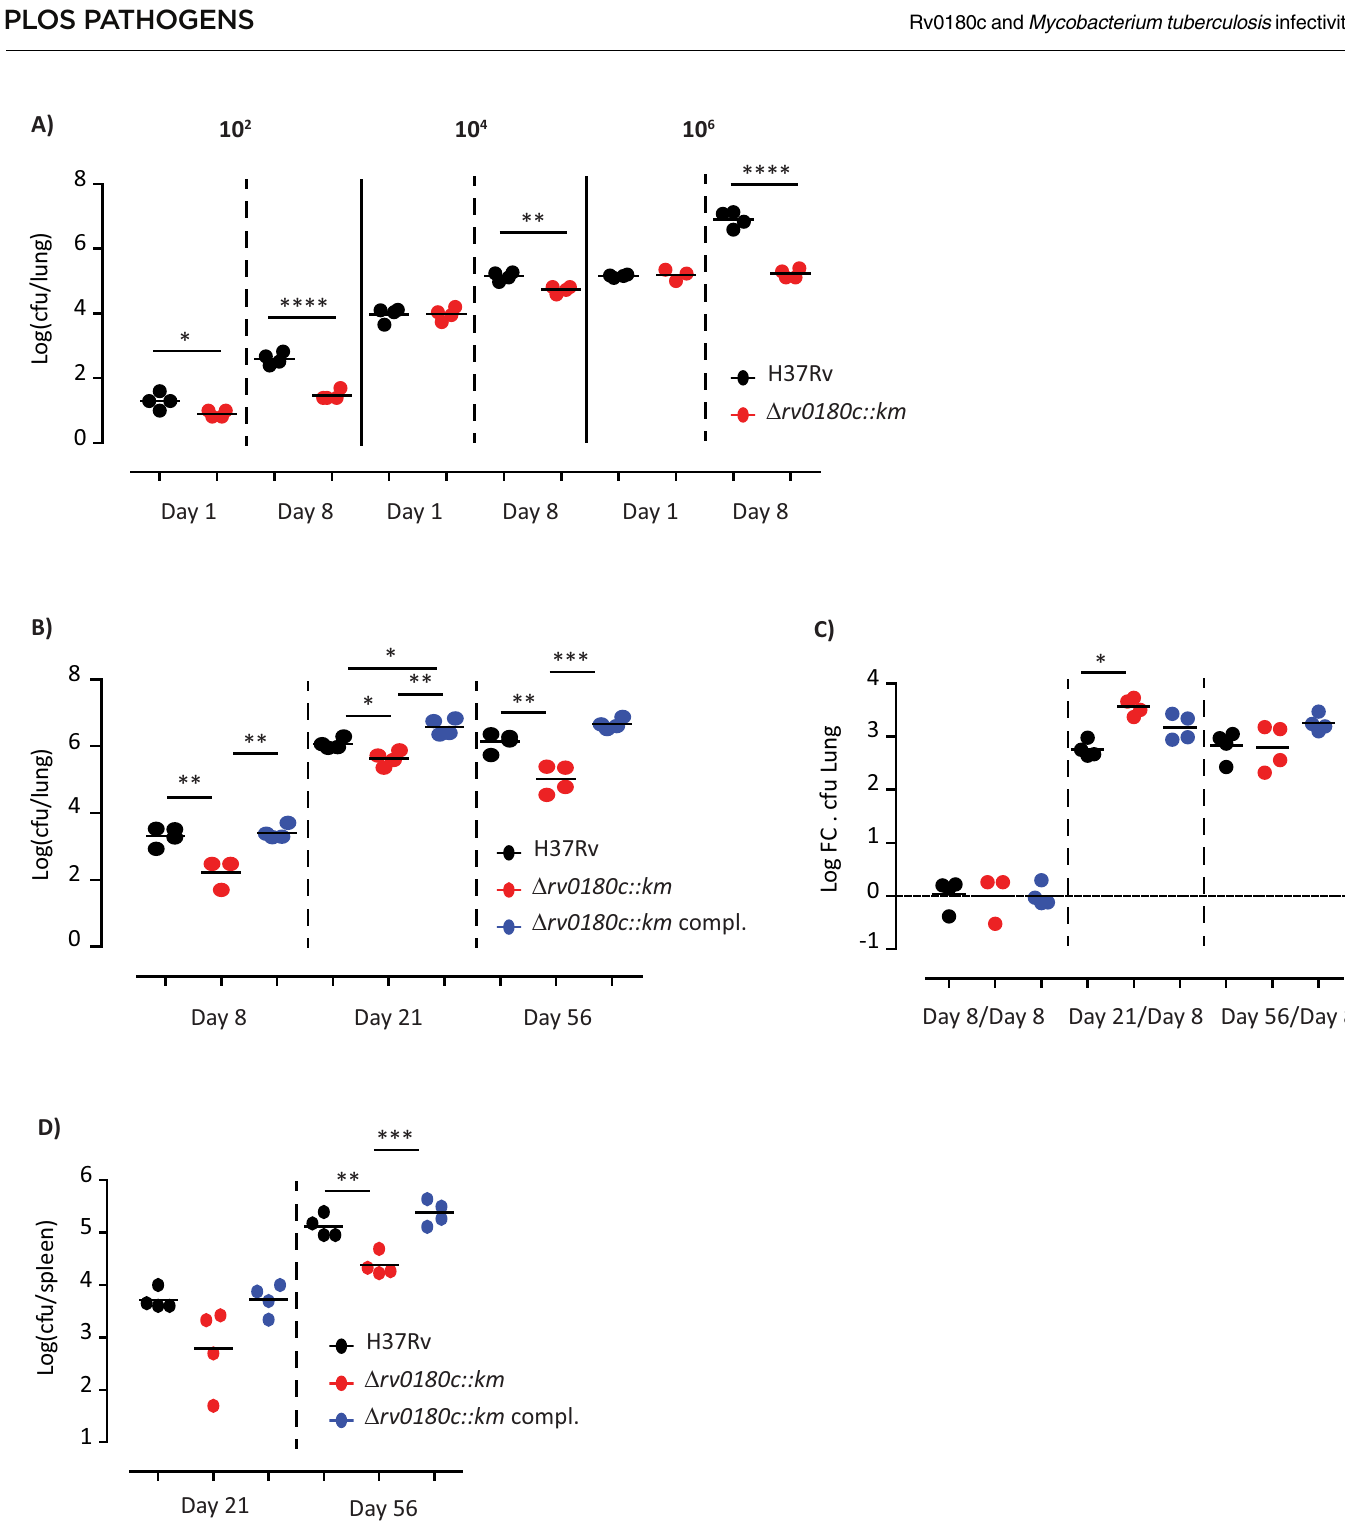
Fig 3. The Δ rv0180c :: km mutant is impaired for implantation in the lung of mice. (A) Parental M . tuberculosis H37Rv (WT) and the Δ rv0180c :: km mutant were used to infect mice intranasally using different infectious dose (10 2 , 10 4 , and 10 6 cfu per mouse). At 1 and 8 days after infection, four mice for each group were sacrificed and the bacterial load in the lungs was evaluated by plating. Results are shown as the Log 10 cfu for individual mice and the mean. These results are representative of two experiments. � p < 0.05, �� p < 0.01, ���� p < 0.001 by one-way analysis of variance (ANOVA) followed by the Bonferroni post hoc test. (B, C, D) Parental M . tuberculosis H37Rv (WT), the Δ rv0180c :: km mutant, and the Δ rv0180c :: km complemented strains were used to infect mice intranasally using 10 3 cfu per mouse. At 8, 21 and 56 days after infection, four mice for each group were sacrificed and the bacterial load in the lungs (B) and spleen (D) was evaluated by plating. Results are shown as the Log